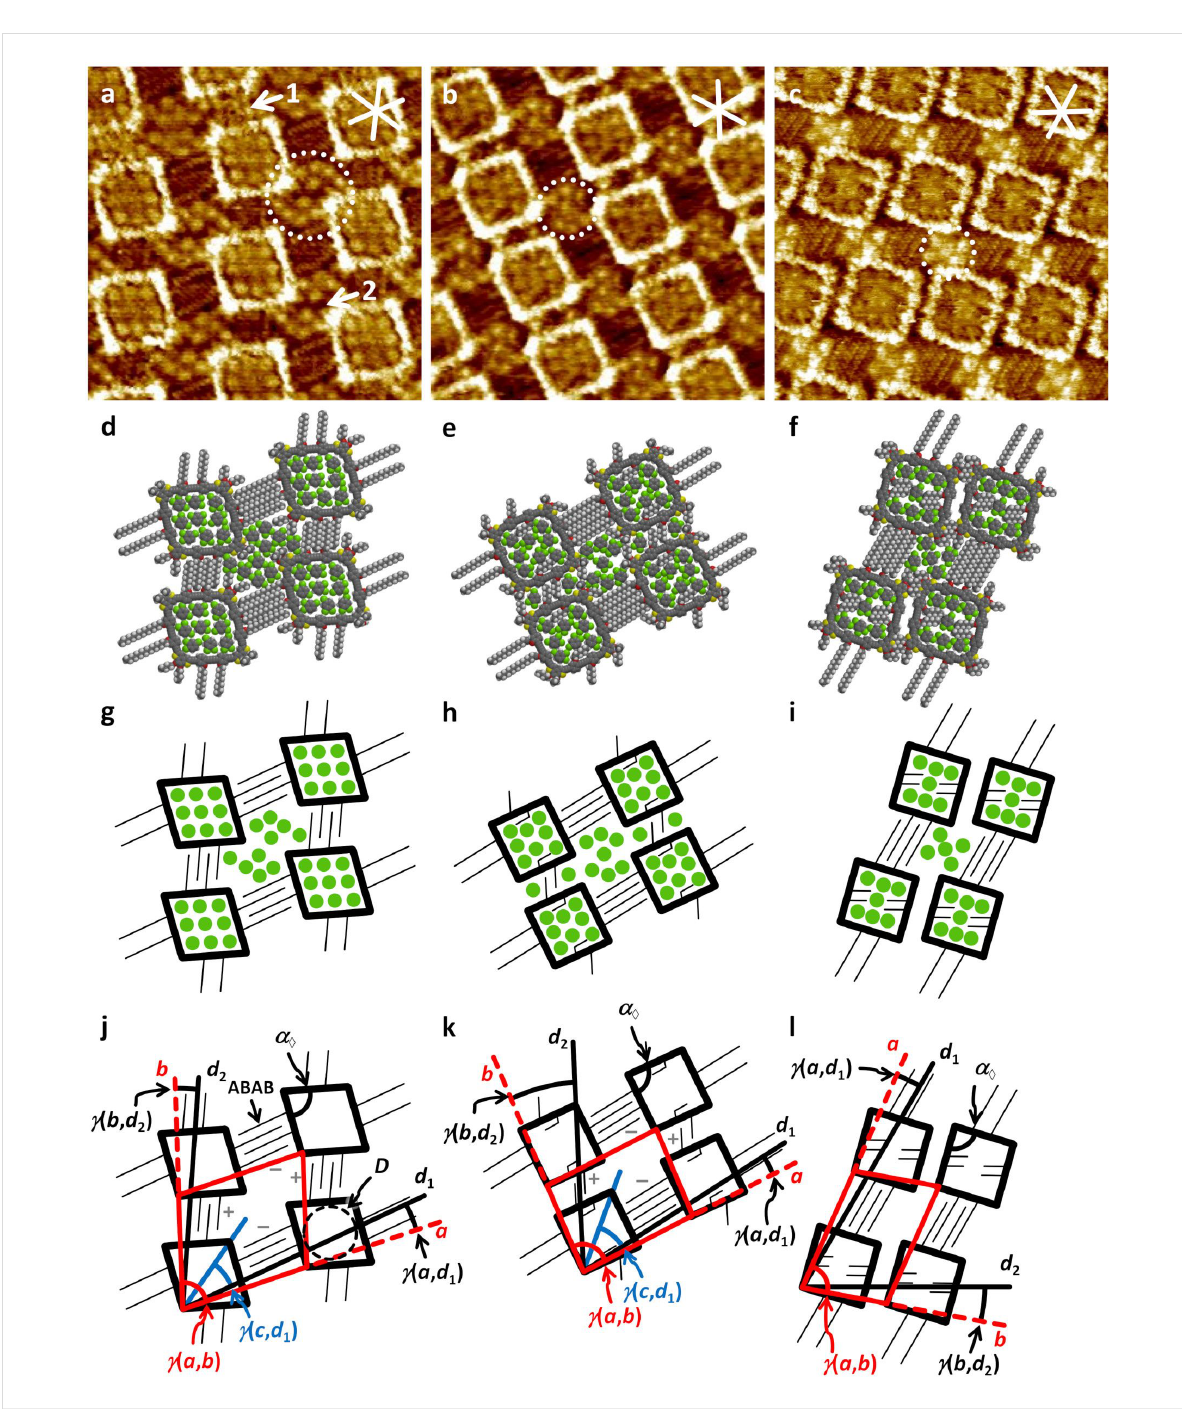
Figure 2: (a)–(c) Scanning tunneling microscopy images, (d)–(f) supramolecular models, and (g)–(l) schematic models of supramolecular nanopat- terns of 1a ((a), (d), (g), (j)), polymorph A of 1b ((b), (e), (h), (k)), and polymorph B of 1b ((c), (f), (i), (l)) at the TCB/HOPG interface. Image parame- ters, unit cells, and additional packing parameters are: (a), (d), (g), (j) 1a ; c = 1 × 10 − 6 M, V S = − 0.8 V, I t = 16 pA; a = (5.6 ± 0.2) nm, b = (4.8 ± 0.2) nm, γ ( a , b ) = (74 ± 2)°; γ ( c , d 1 ) = (30 ± 4)°; γ ( a , d 1 ) = γ ( b , d 2 ) = (7 ± 2)°; α ◊ = (80 ± 4)°; (b), (e), (h), (k) 1b ; c = 5 × 10 − 7 M, V S = − 0.6 V, I t = 25 pA; a = (5.5 ± 0.2) nm, b = (4.2 ± 0.2) nm, γ ( a , b ) = (84 ± 2)°; γ ( c , d 1 ) = (36 ± 4)°; γ ( a , d 1 ) = (4 ± 1)°; γ ( b , d 2 ) = (21 ± 2)°; α ◊ = (87 ± 3)°; (c), (f), (i), (l) 1b ; c = 1 × 10 − 6 M, V S = − 0.4 V, I t = 26 pA; a = (5.6 ± 0.2) nm, b = (4.0 ± 0.2) nm, γ ( a , b ) = (74 ± 2)°; γ ( a , d 1 ) = (5 ± 1)°; γ ( b , d 2 ) = (9 ± 1)°; α ◊ = (88 ± 4)°. All samples were thermally annealed for 20 s at 80 °C prior to imaging. All image sizes are 15.4 × 15.4 nm 2 . The red lines indicate the unit cells, a , b , and γ ( a , b ). The white and black lines indicate the HOPG main axis directions, d 1 , and d 2 . Bold and thin black lines in (c) represent backbones and (adsorbed) alkoxy side chains (whereas freely moving side chains, and side chains that point towards the solu- tion phase are omitted). Green dots indicate the positions of intercalated TCB molecules. The diameter of the circle fitted to the rhombic intramolecu- lar nanopore in (j) is D ≈ 2.3